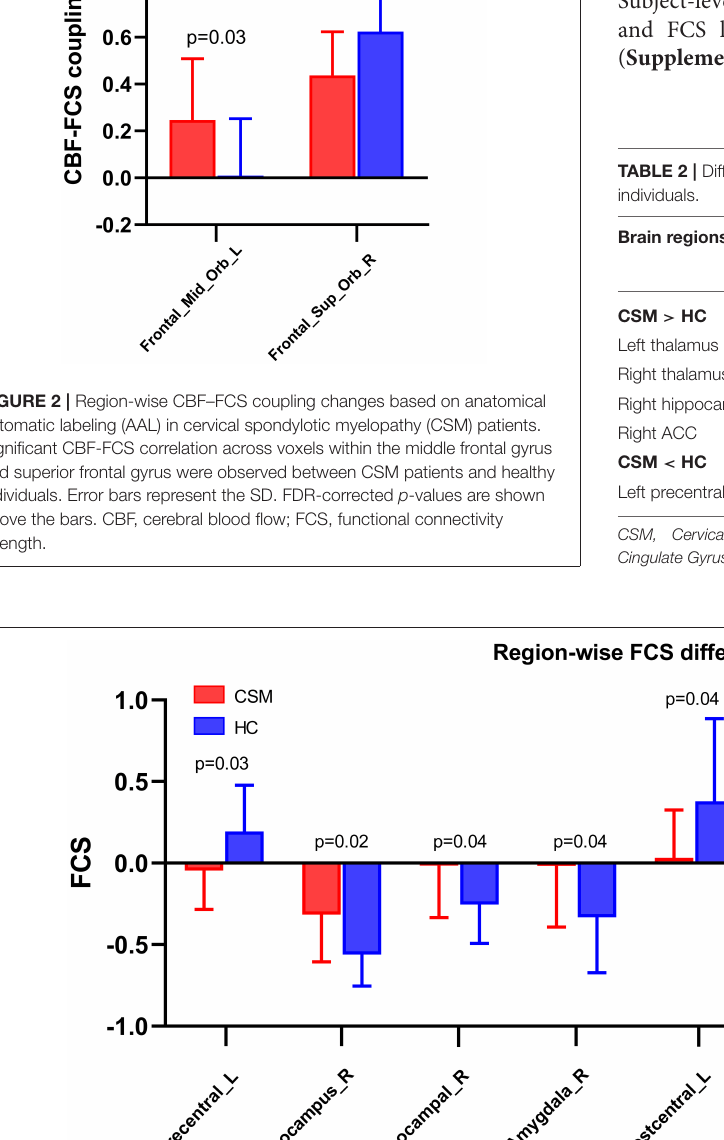
Frontiers in Neurology |